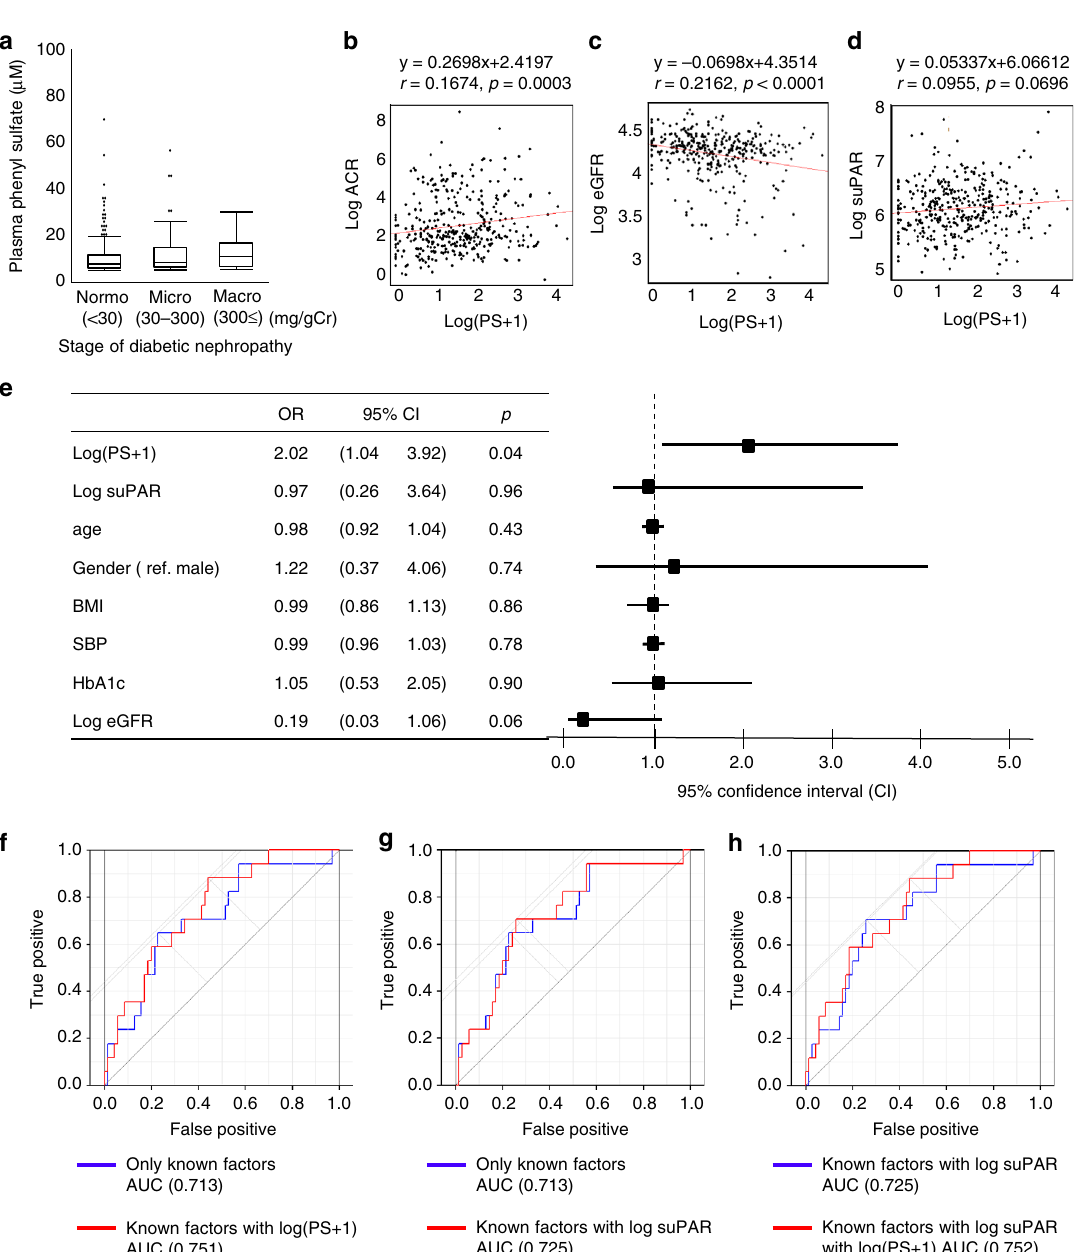
Fig. 3 The clinical signi fi cance of PS in DKD patients. a The relationship between the plasma PS concentration ( n = 362). b The relationship between the plasma PS concentration and the urinary albumin level ( n = 362). c The relationship between the plasma PS concentration and the eGFR ( n = 362). d The relationship between the plasma PS concentration and soluble urokinase-type plasminogen activator receptor (suPAR) ( n = 362). e PS is a predictor of 2- year albuminuria. Adjusted odds ratio (95% con fi dence interval). Note that, among the known factors 23 , PS was the only factor that served as a predictor of the progression of 2-year ACR in patients with microalbuminuria ( n = 87). Receiver operating characteristic (ROC) curve analysis in the U-CARE Study, showing comparison of known factors 23 . f AUC-ROC using known factors (0.713) and adjusted with PS (0.751) ( n = 87). g AUC-ROC using known factors (0.713) and adjusted with suPAR (0.725). ( n = 87). h AUC-ROC using known factors with suPAR (0.725) and adjusted with PS (0.752) ( n =